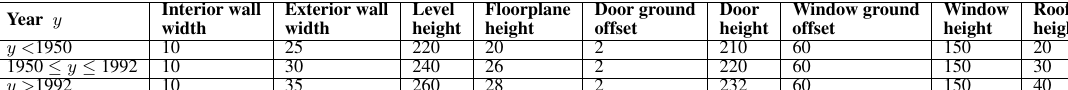
Figure 1. Global design, including component I and II (section 3.1 and 3.2)